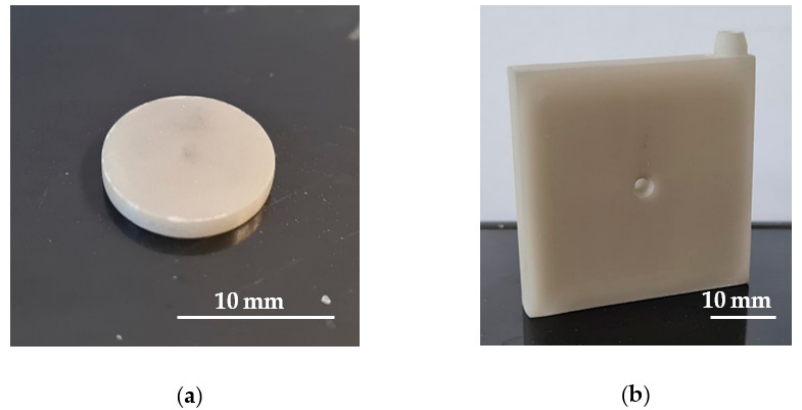
Figure 10. Sintered AlN parts made via CerAM VPP: ( a ) disc structure for TLF measurement; ( b ) complex substrate with inner cooling channels.